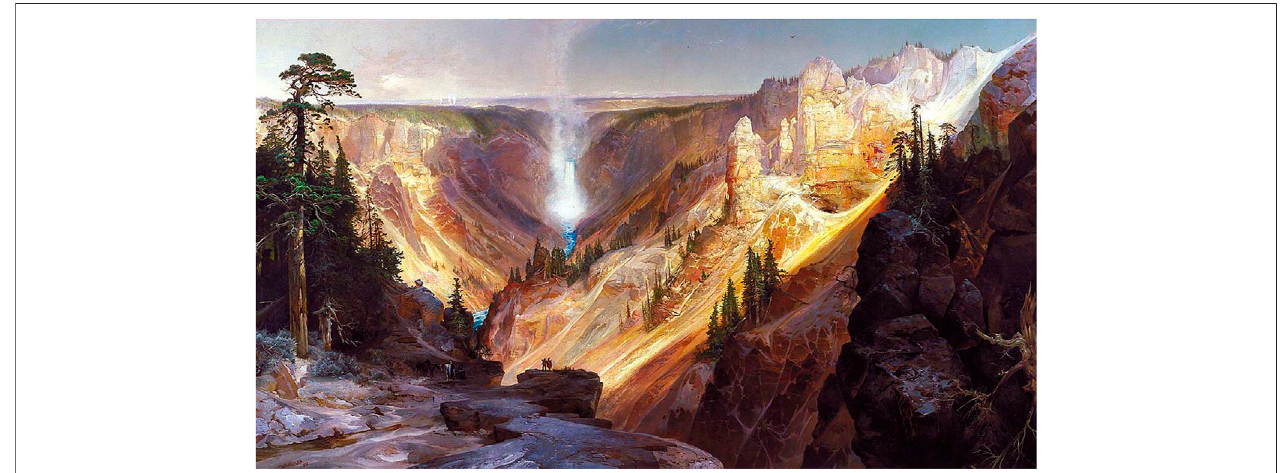
FIGURE 5 | The Grand Canyon of the Yellowstone, Thomas Moran, 1872. Oil on Canvas.